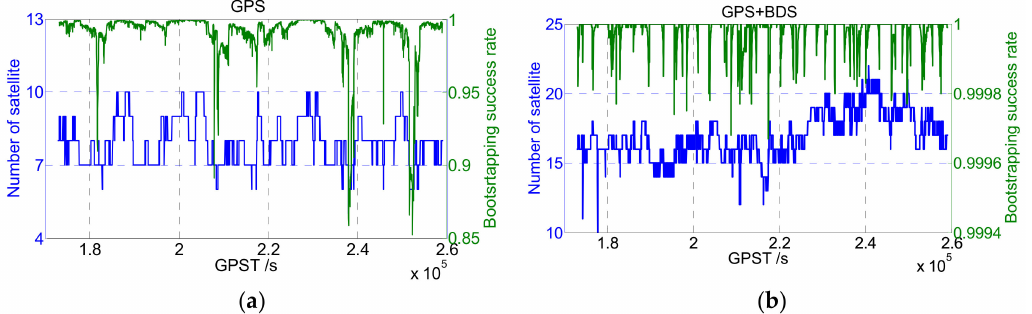
Figure 1. Bootstrapping success rate of GPS ( a ) and GPS + BDS ( b ) dual-frequency